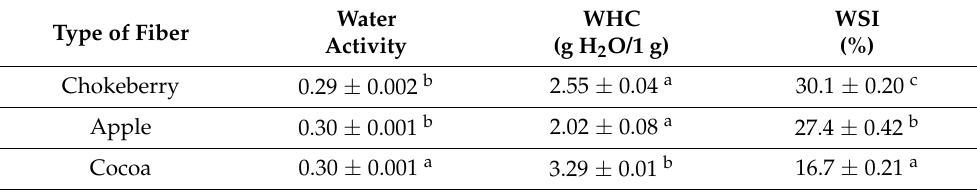
Table 3. Physicochemical properties of the studied fiber